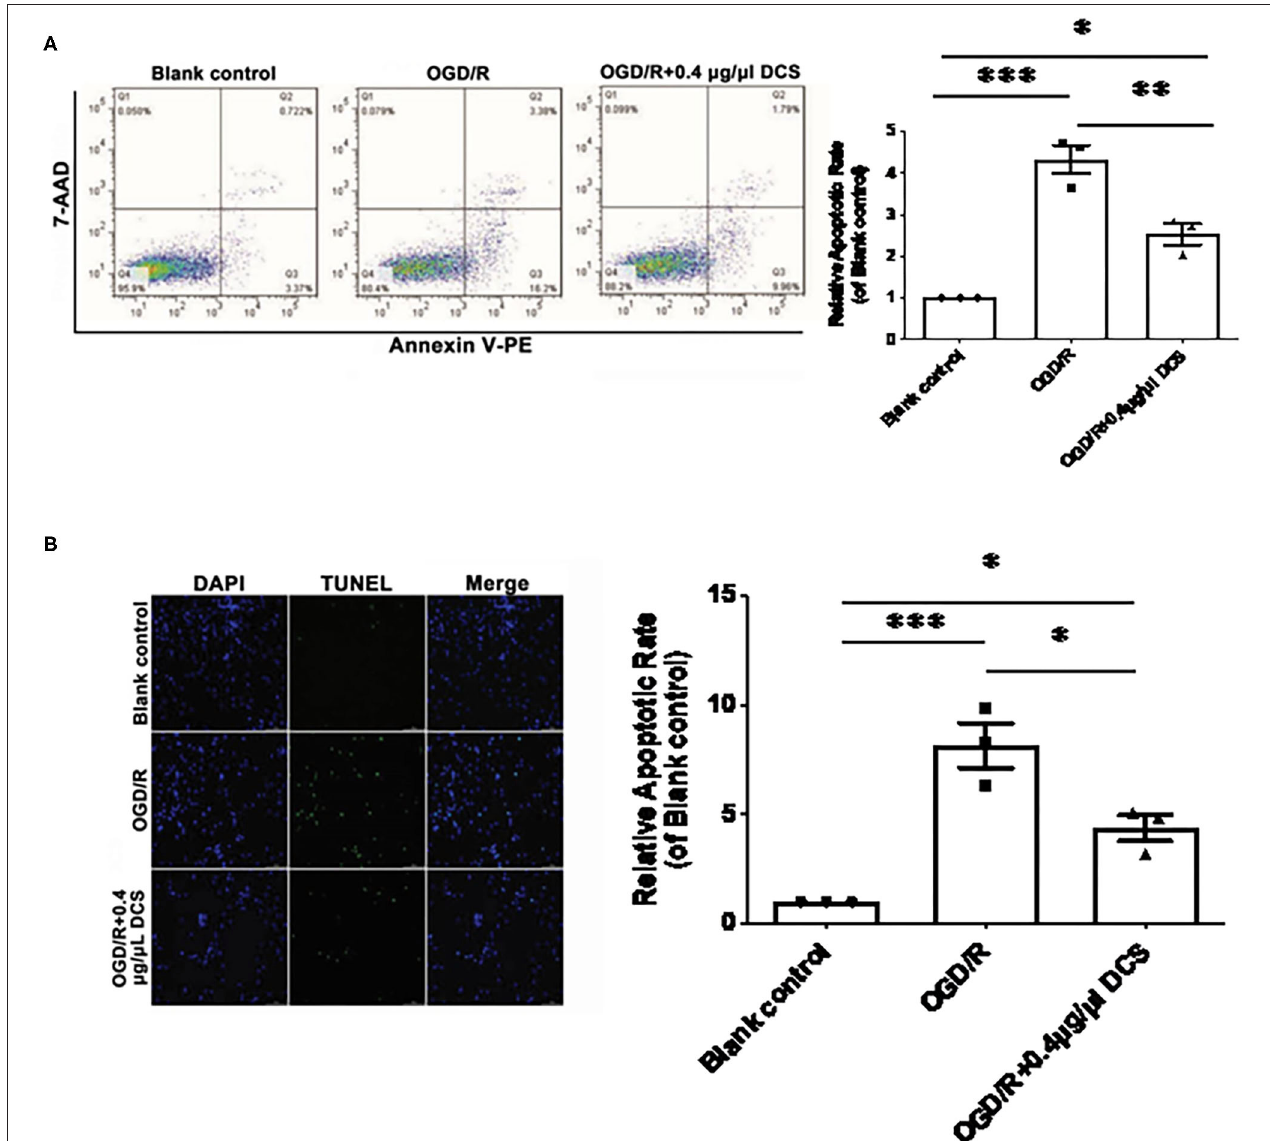
FIGURE 3 | Effect of DCS on the apoptosis of cultured primary neurons exposed to OGD/R. (A) The apoptosis of cultured primary neurons isolated from rat E18 embryos assessed using a phycoerythrin/Annexin-V assay and flow cytometry. In the FACS picture, the upper-left quadrant represents mechanically damaged cells, the upper-right quadrant apoptotic or necrotic cells, the lower-left quadrant normal cells, and the lower-right quadrant early apoptotic cells. (B) The apoptosis of cultured primary neurons isolated from rat E18 embryos assessed using the terminal deoxynucleotidyl transferase dUTP nick end labeling (TUNEL) assay. The nuclei were stained with 4 ′ ,6-diamidino-2-phenylindole (DAPI; blue). Blank control: cells not exposed to OGD/R; OGD/R: cells exposed to OGD/R; OGD/R + 0.4 µ g/ µ l DCS: cells exposed to OGD/R and treated with 0.4 µ g/ µ l of DCS for 4h. Data shown as mean ± SEM, n = 3. * p < 0.05, *** p <